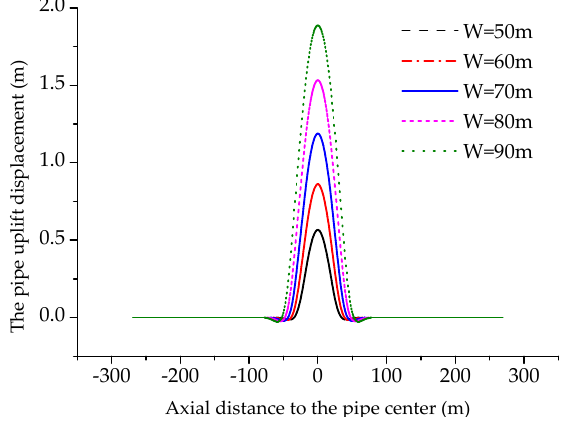
Figure 20. Vertical deformations for pipes buried in soils with various soil spring stiffnesses.